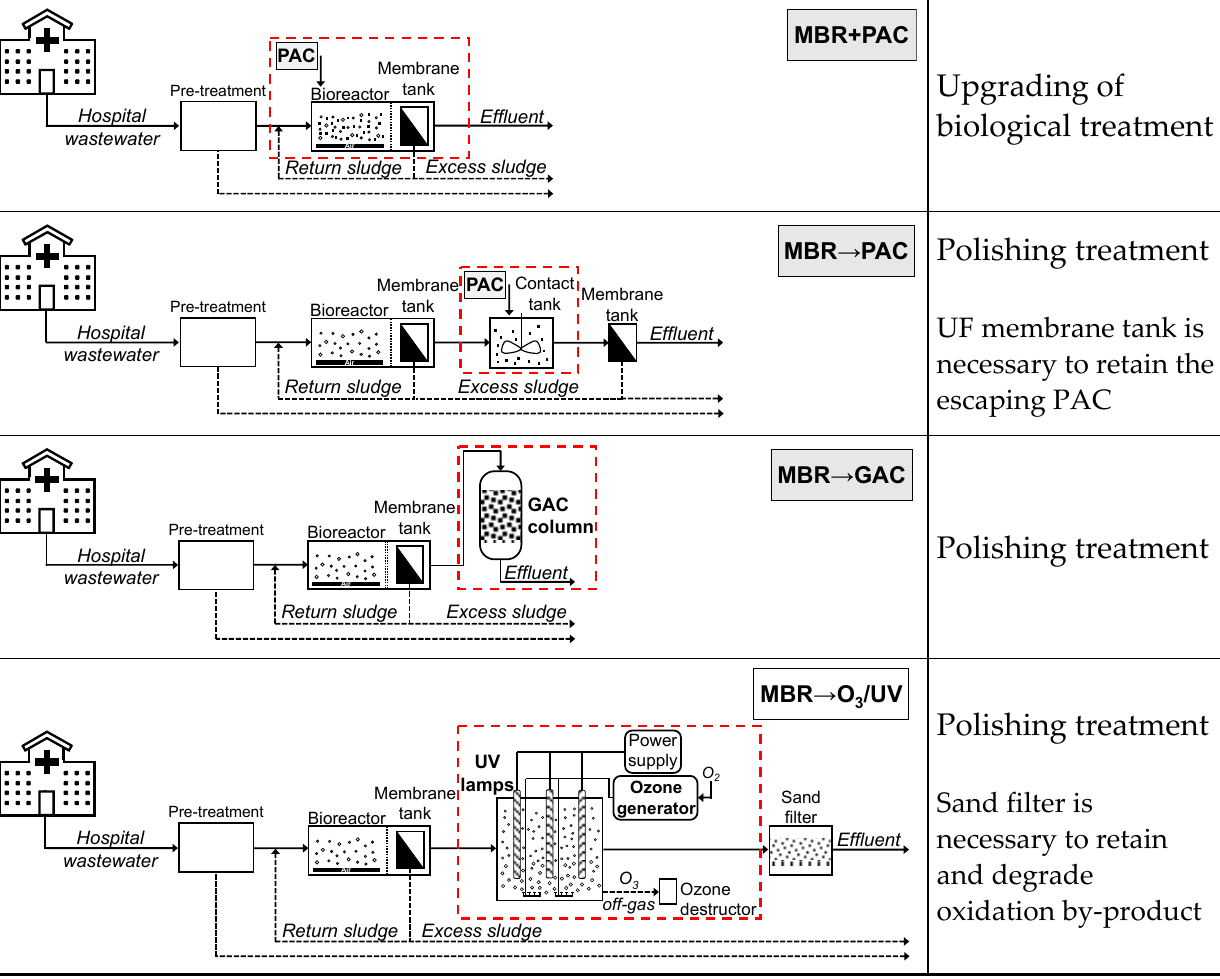
Figure 1. Typical configurations of a membrane bioreactor (MBR) combined with powdered (PAC) or granular (GAC) activated carbon and O 3 /UV. The treatment steps under study are surrounded by red dotted lines.